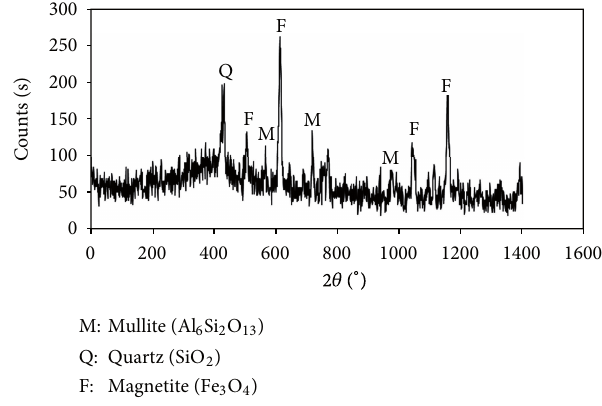
F 23: �-ray di�raction of activated carbon-�y ash-nFe composite